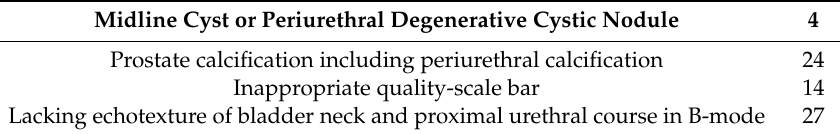
Table 1. Cases of inappropriate periurethral elastography and reasons.